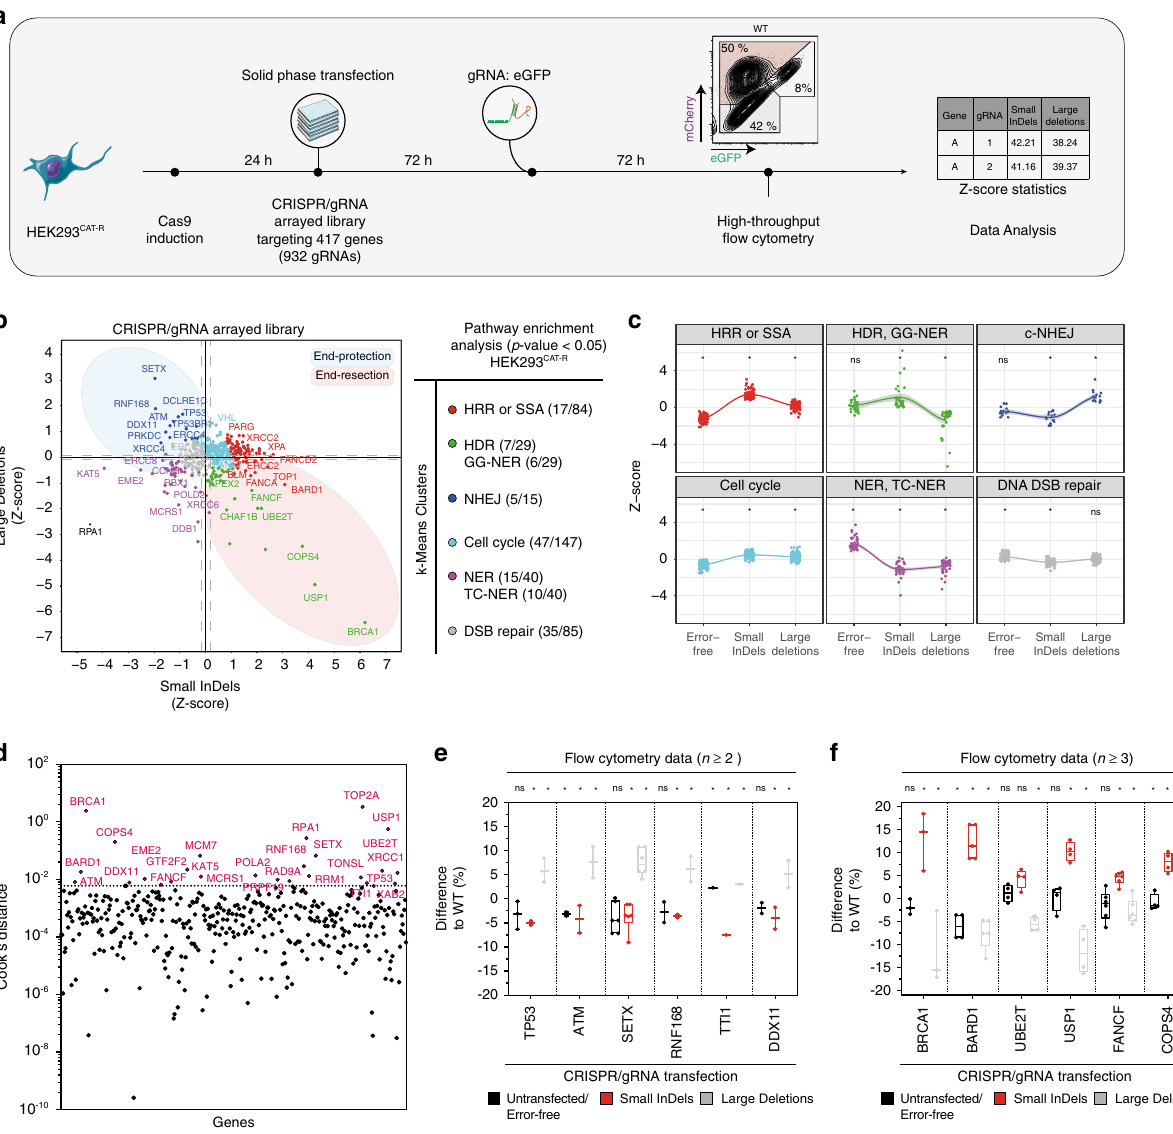
Fig. 4 The landscape of Cas9-mediated double-strand break repair. a The work fl ow of the CRISPR/gRNA genetic screen. In total, 417 genes were targeted with two different gRNA sequences each. HEK293 CAT-R cells were induced with doxycycline (1 μ g/ml), and 24 h later transfected using the solid- phase methodology in pre-coated 96-well plates. 72 h post-transfection, the cells were transfected with the gRNA: eGFP and at day seven analyzed in a high-throughput fl ow cytometer. Data points were averaged, and the Z -score values were calculated per 96-well plate. b A scatter diagram (median) shows the effect of 417 genes upon Cas9-mediated DSB. In the X axis, the regulation of small InDels and in the Y axis, the regulation of the large deletions, are presented. Pathway enrichment analysis of each of the six clusters is shown with the p -value threshold to be set at 0.05. c Individual k -means clusters pro fi le in terms of DNA DSB repair choice with the use of the CAT-R system. Each dot represents a gene-phenotype, * p < 0.05 versus WT control, multiple comparison analysis testing in ANOVA followed by a Dunnett ’ s test. All individual p -values are included in Source Data fi le 3. d Cook ’ s distance plot illustrates genes with the most robust phenotype upon Cas9-mediated DSB. The genes passing the signi fi cance threshold are annotated. Box and whiskers plots ( n TP53 = 3, n ATM = 2, n SETX = 6, n RNF168 = 2, n TTI1 = 2, n DDX11 = 2, n BRCA1 = 3, n BARD1 = 4, n UBE2T = 4, n USP1 = 4, n FANCF = 6, n COPS4 = 4, centerlines mark the medians, box limits indicate the 25th and 75th percentiles, and whiskers extend to min and max, showing all points) of fl ow cytometry analysis for the HEK293 CAT-R cells are shown in e , and f . Values are normalized to wildtype (WT) control, * p < 0.05 versus WT control, multiple comparison analysis testing in ANOVA followed by a Dunnett ’ s test. All individual p -values are included in Source Data fi le 3. Data are derived from two independent experiments; n represents the number of all